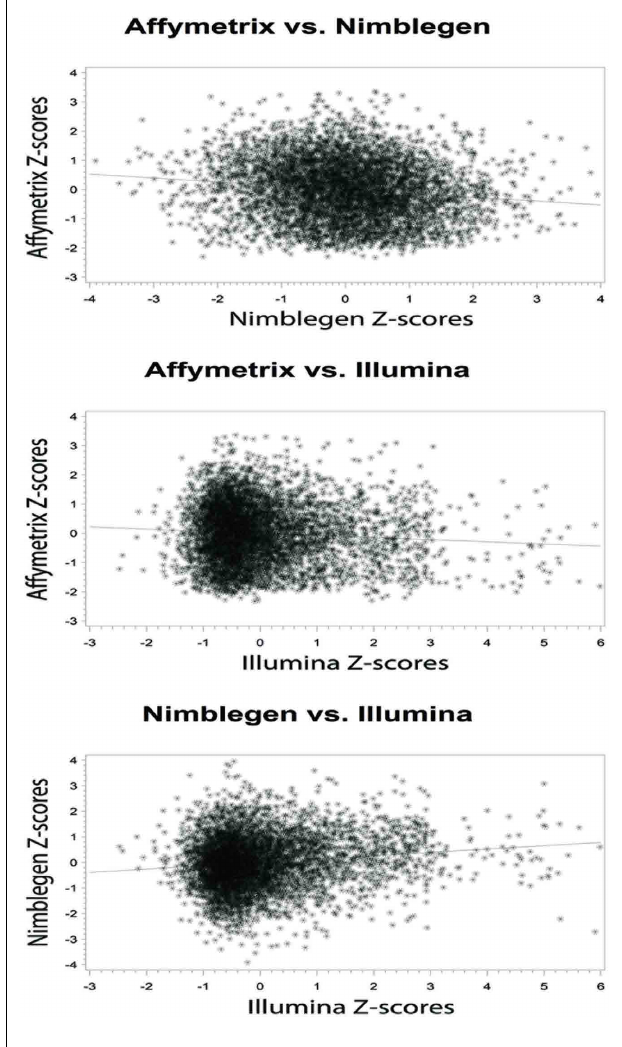
FIGURE 2 | Bivariate analytic plots of the relationship between: (A) Affymetrix gene expression and NimbleGen methylation data ( r 2 = − 0.131) (B)Affymetrix gene expression and Illumina methylation data ( r 2 =− 0.073) and (C) NimbleGen and Illumina methylation data ( r 2 =